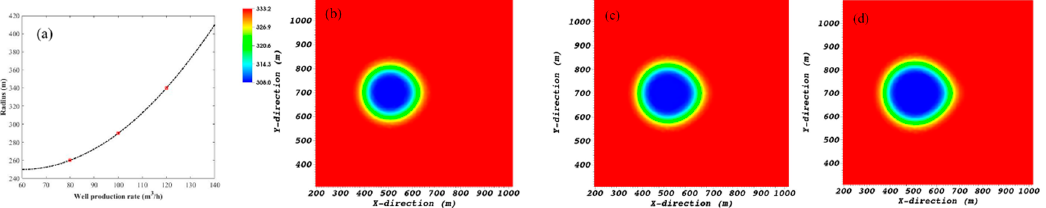
Figure 11. Temperature distribution nephograms of an IGDHS with a reinjection temperature of 301.15 K in the 50th year: ( a ) radius of cold water thermal front; ( b ) production rate of 80 m 3 /h; ( c ) production rate of 100 m 3 /h; ( d ) production rate of 120 m 3 /h.